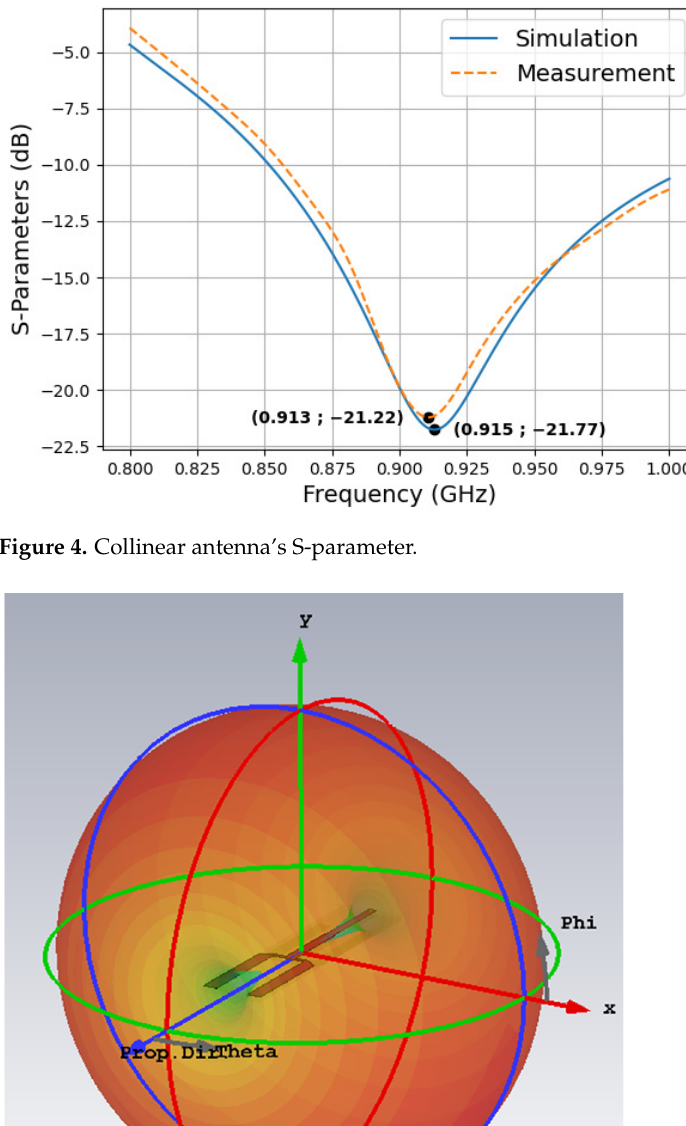
Figure 6. Friis transmission formula application environment.